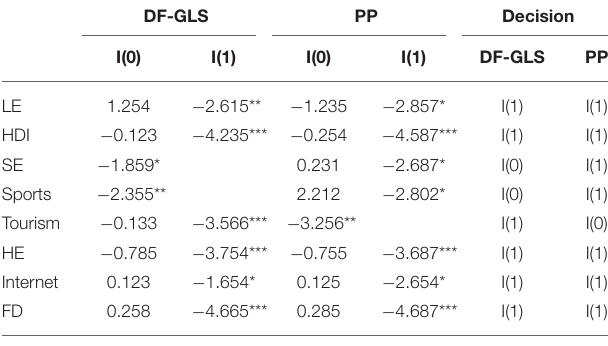
TABLE 2 | DF-GLS and PP tests.